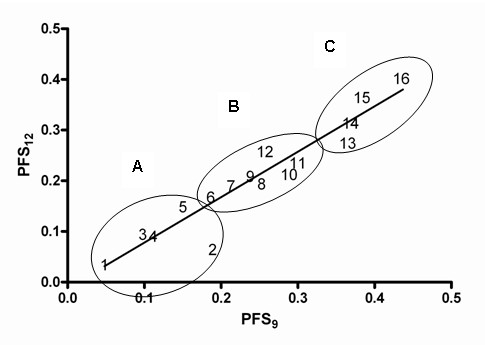
Linear regression plots of the treatment pairs PFS9 versus PFS12. Circled areas A, B, and C are regions coincidental with the clusters yielded by the hierarchical cluster analysis.